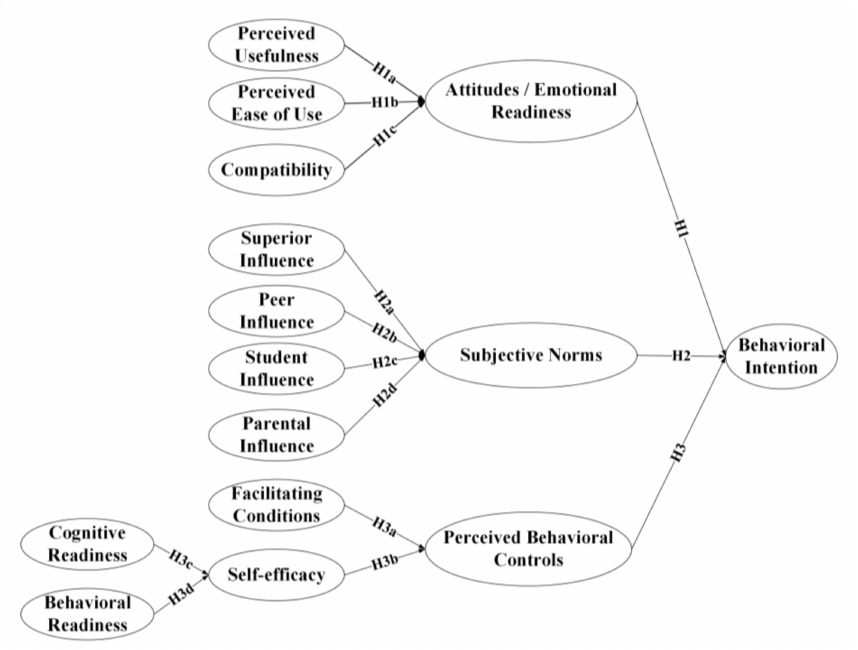
Figure 1. The proposed model with the initial